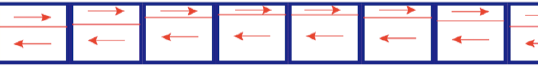
Figure 6: 1D alignment of